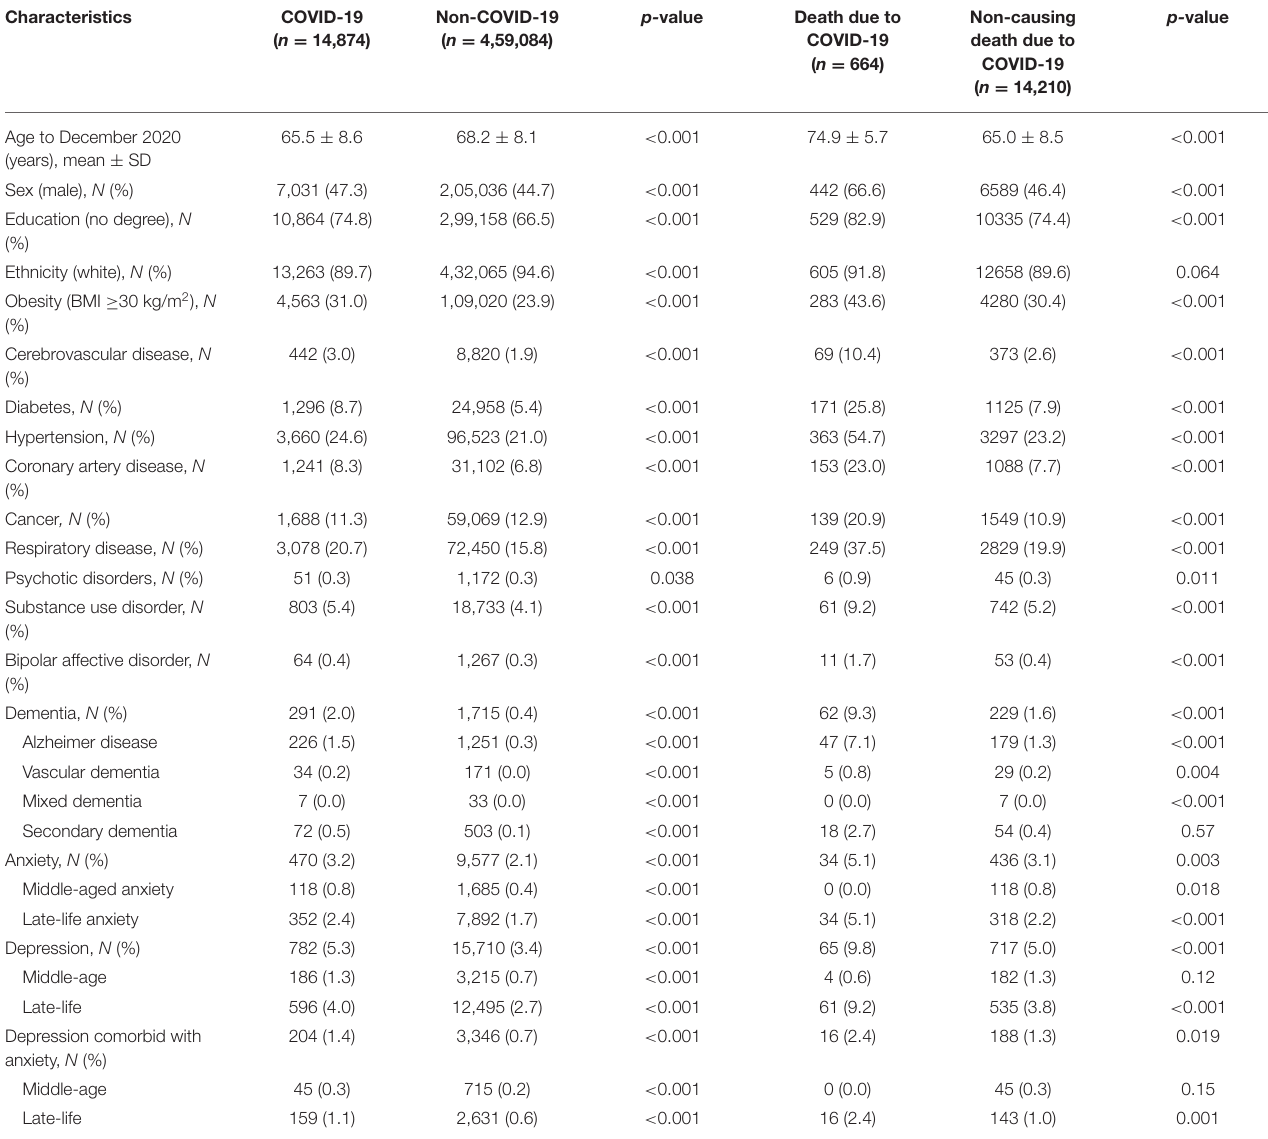
TABLE 1 | Characteristics of UK Biobank